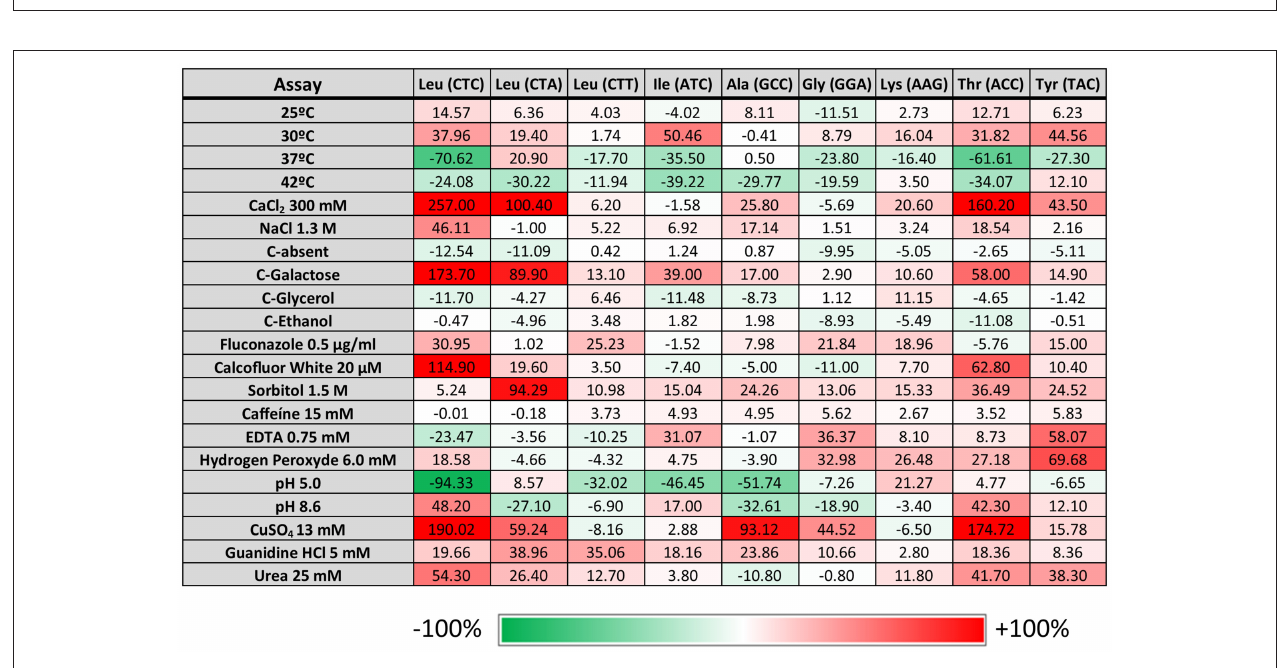
FIGURE 1 | The effect of mistranslation on protein aggregation. The graph shows small increases in protein aggregation induced by mistranslation. The data represents insoluble protein + s.d. of duplicates of 3 different clones, normalized to the pUA552 control. Statistical analysis was carried out using one-way ANOVA was followed by a Dunnet test with CI 95% relative to pUA552 ( * p < 0.05). Gel showing insoluble protein fractionated on a 15% acrylamide gel.